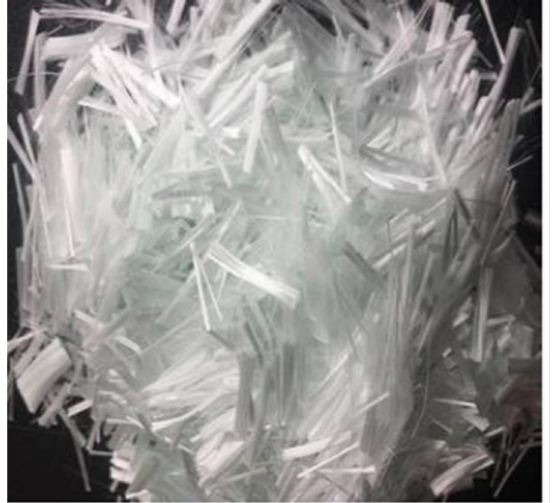
Figure 17. AR glass fibers. Reprinted with permission from Ref. [180]. Copyright 2021, with permission from